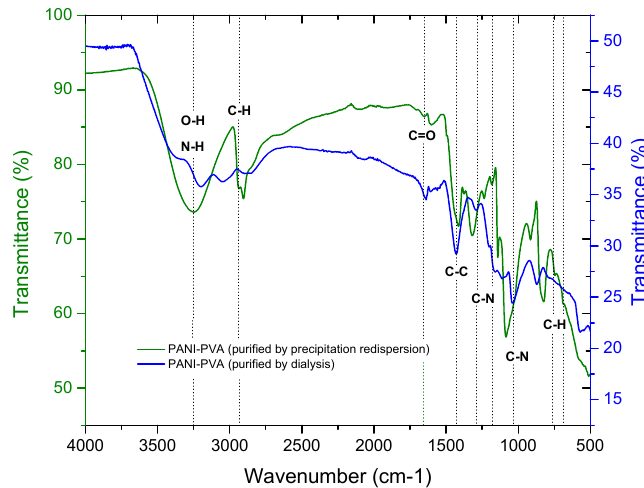
Figure 3. FTIR spectra of PVA–PANI purified by dialysis (-) and by precipitation–redispersion (-).